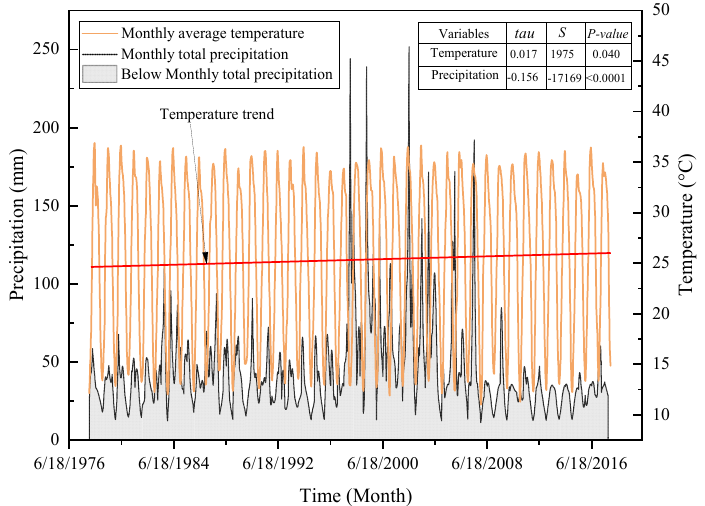
Figure 6. SDSM calibration and validation using NCEP and GCMs; For mean and maximum pre ‐ cipitation.